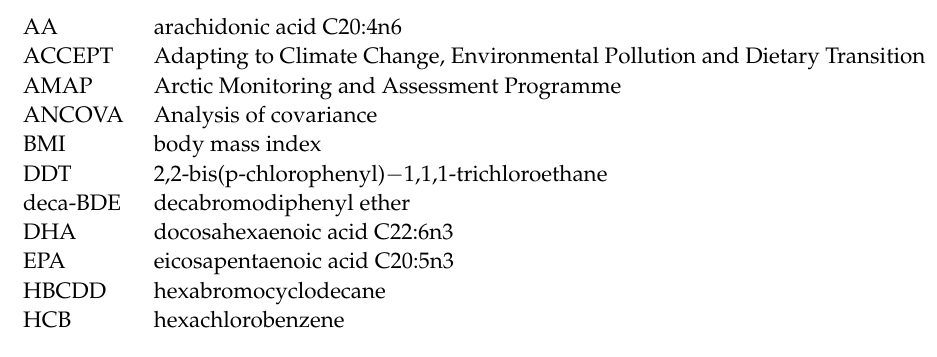
population. Table S2: Greenlandic Men: age stratified time trend of lipPOPs and heavy metal level during 1997–2006. Table S3: Women and Men across Greenland: Time trend of lipPOPs, metals and PFASs level during 1994–2015. Table S4: Levels of lipPOPs and metals in pregnant and nonpregnant women. Table S5: Greenland women: Time trend of lipPOPs, metals and PFASs levels stratified by the pregnancy status. Figure S1. Time trend of lip POPs, metals and PFASs in Nuuk women during 1998-2015. Figure S2. Time trend of lip POPs and metals in Ilulissat women during 1994-2015. Figure S3. The levels of PFASs in Ilulissat women in 1999 (n = 10), 2011 (n = 33), 2014 (n = 20) and 2015 (n =